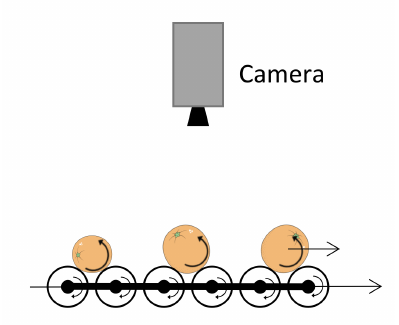
Figure 1. Roller conveyor unit used to obtain different views of the rotated fruits.